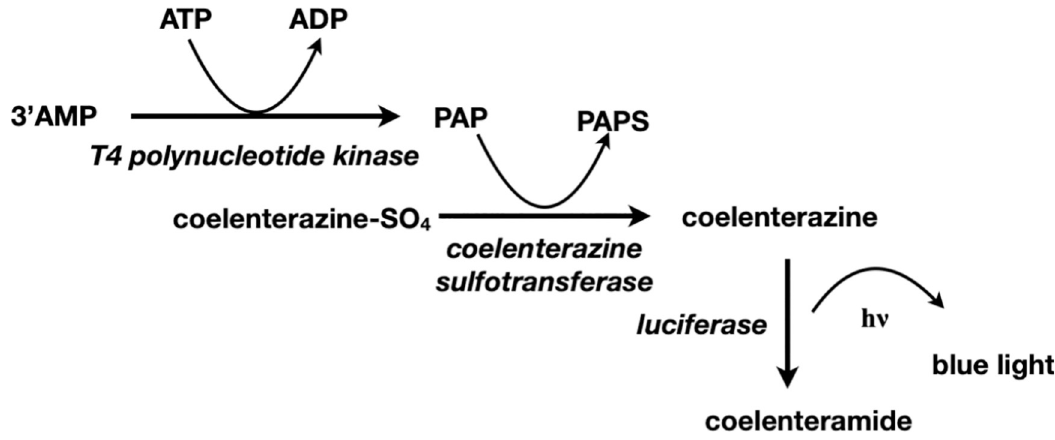
Fig 11. ATP bioluminescence assay using Coel-ST in a three-enzyme